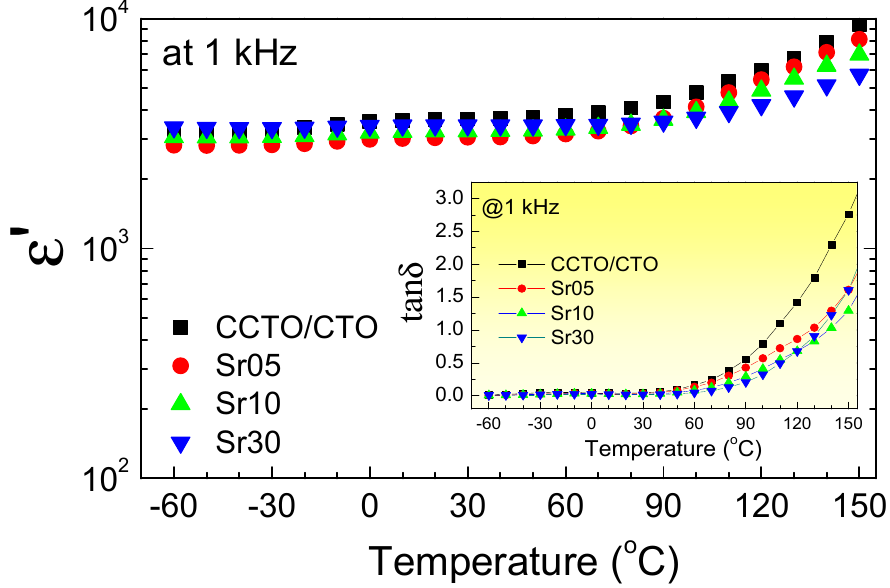
ing ions reduced the long-range motion of free charge carriers, which may be due to the increase in the GB resistance.